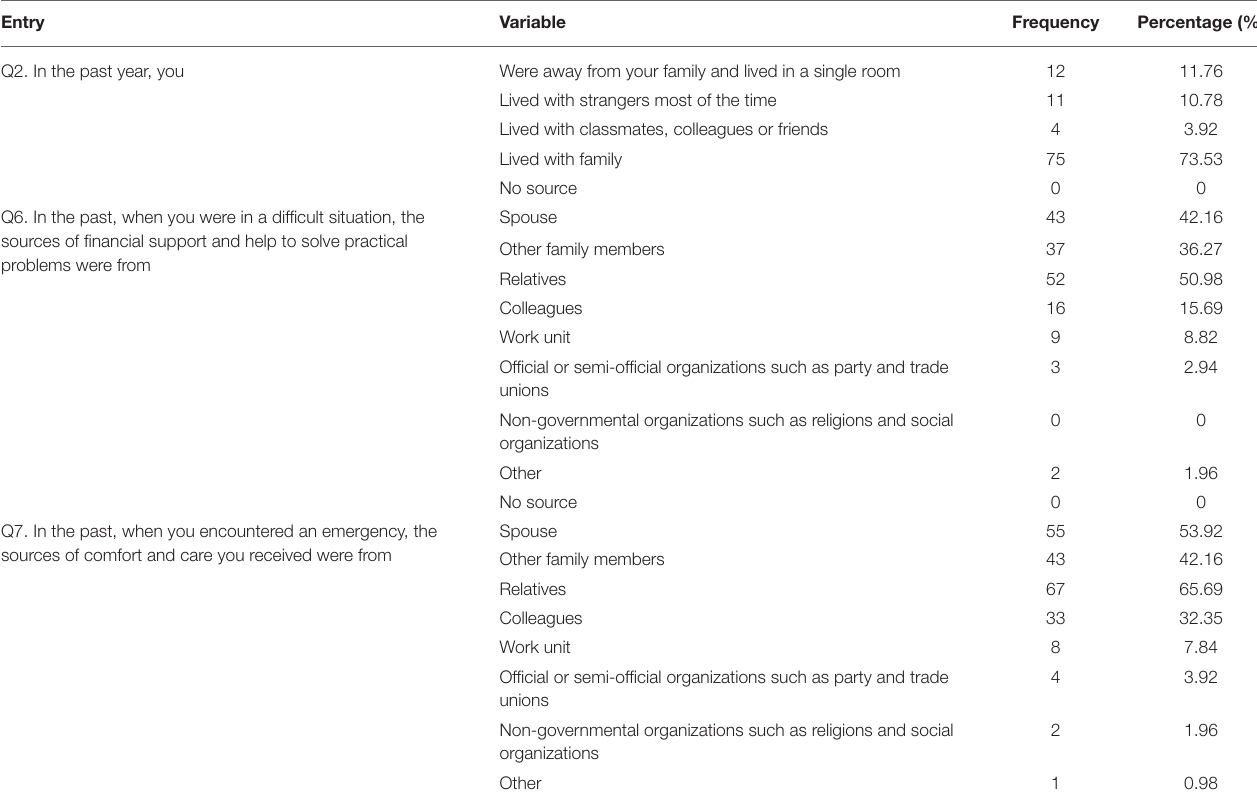
TABLE 4 | Objective